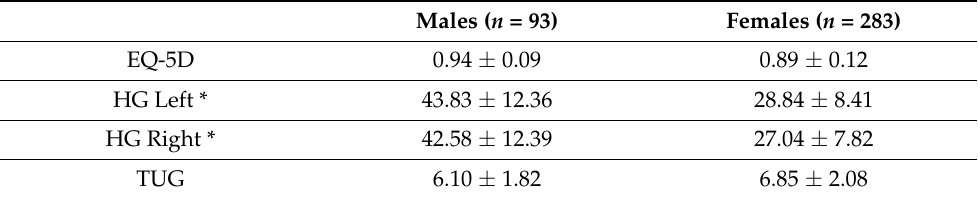
Table 3. Mean ± SD values of health perception (EQ-5D-5L), left (HG Left) and right (HG Right) grip strength, and the Timed Up and Go test (TUG) based on sex.